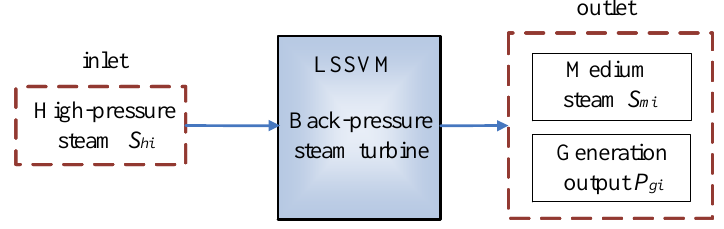
Figure 3. Operation model of the back-pressure steam turbine using the LSSVM.